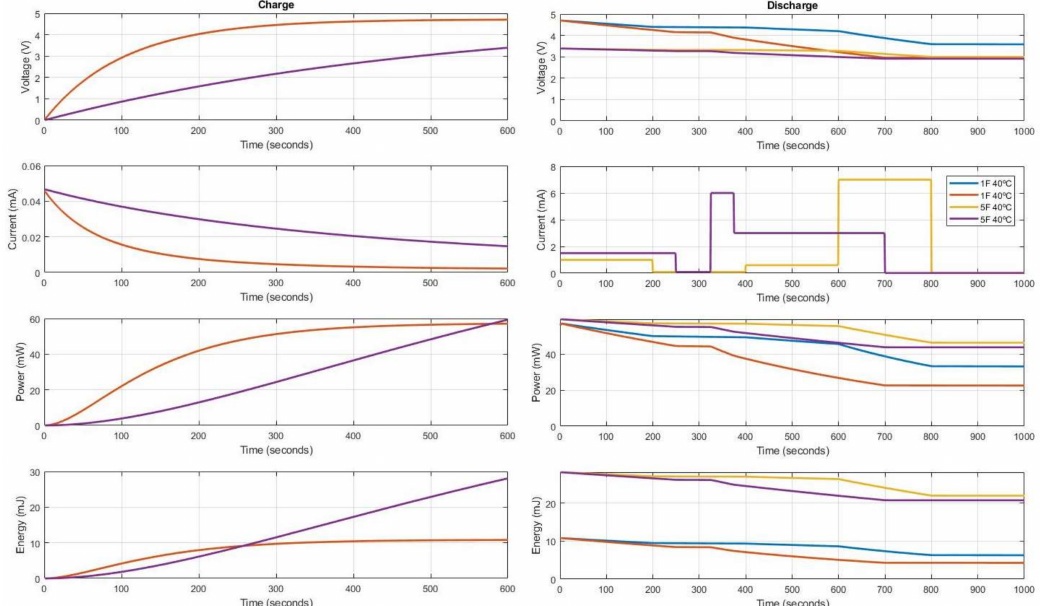
Figure 7. Mathematical model results with 1 F and 5 F supercapacitors, 600 s charge with 5 V at 40 ◦ C temperature and different profiles of discharge. Yellow discharge profile has five steps all with 200 s of duration; First 1 mA, second self-discharge, third 0.5 mA, fourth 7 mA and fifth self-discharge. Purple discharge profile has also 5 steps; First 1.5 mA for 250 s, second self-discharge for 75 s, third 6 mA for 50 s, fourth 3.5 mA for 325 s and fifth self-discharge for 300